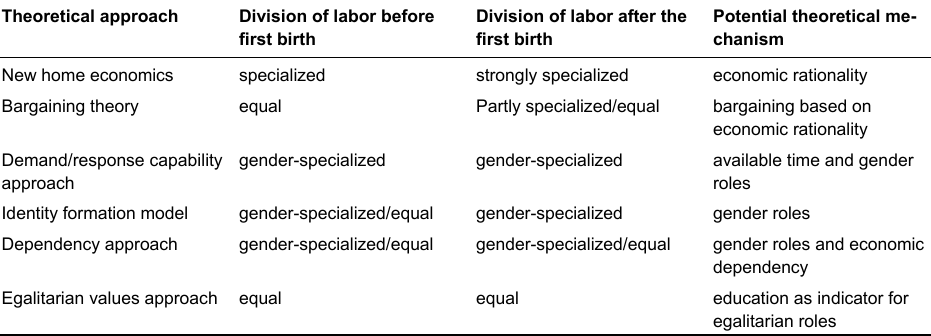
Table 1 : Overview of theoretical expectations of the division of labor within highly educated couples before and after the birth of the first